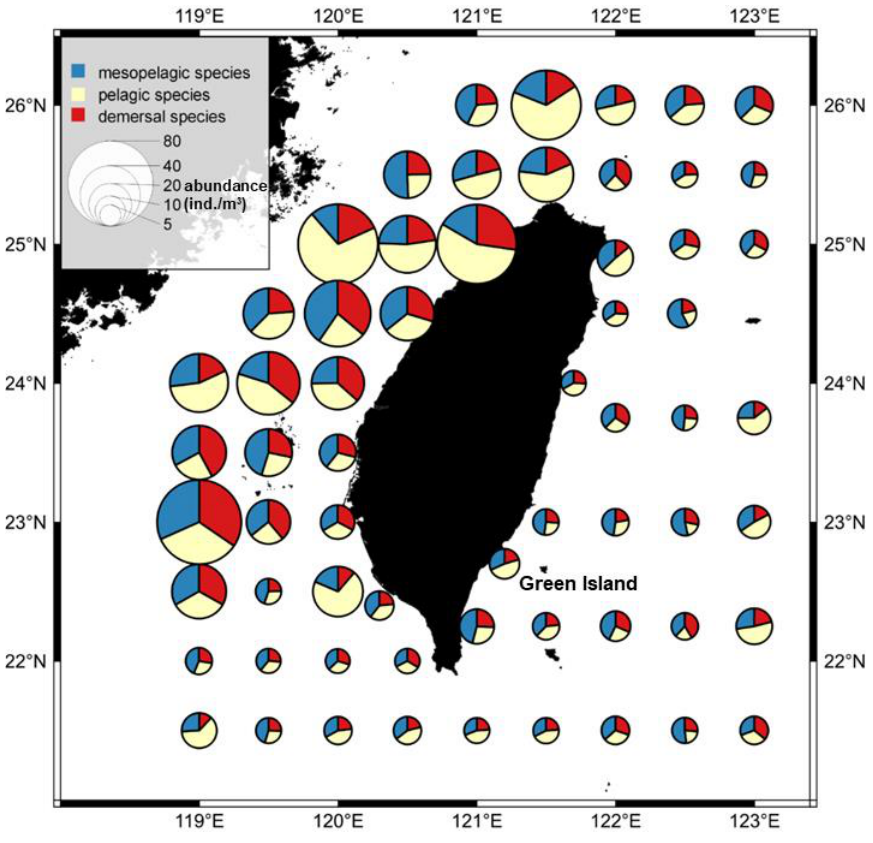
Figure 8. Spatial distribution of the abundance of fish larvae and juveniles in the pelagic, mesopelagic, and demersal zones in the waters around Taiwan between 2007 and 2019.